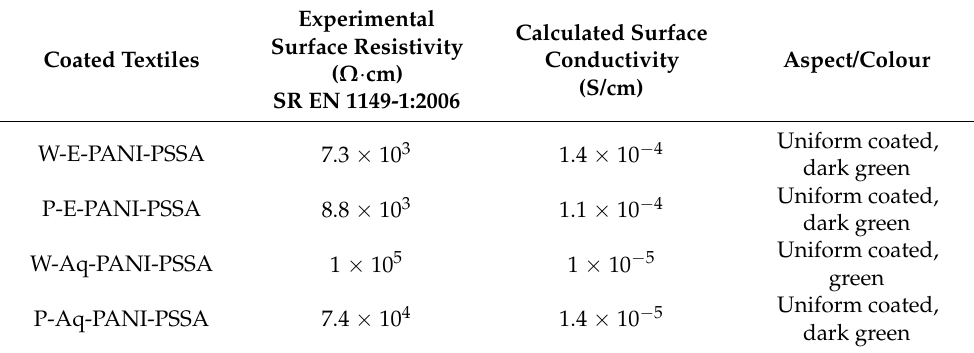
Table 2. Resistivity measured according to Romanian standard SR EN 1149-1:2006 [27] and calculated conductivity of coated obtained